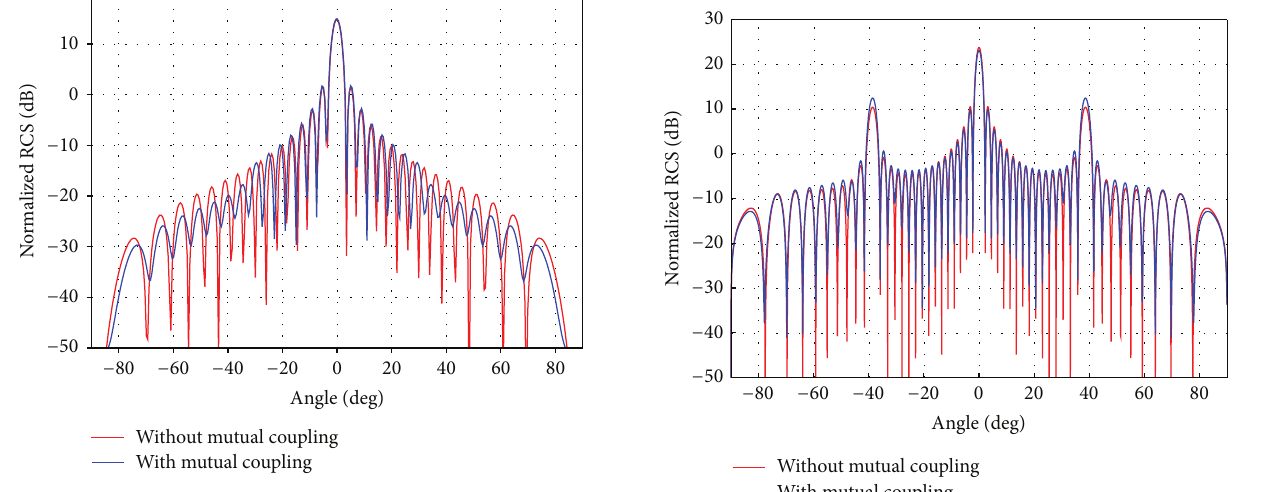
Figure 15: Broadside RCS of a series-fed 40-element linear dipole array in side-by-side configuration with Taylor amplitude distribu- tion ( 𝜃 𝜎 = 0 ∘ ).